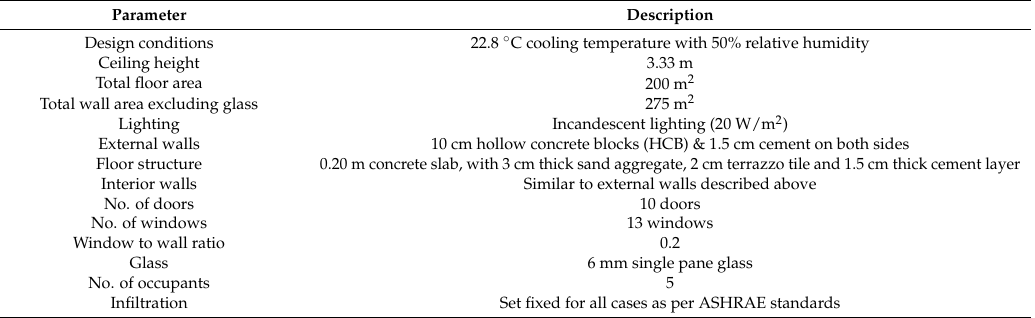
Figure 2. The layout of the house: ( a ) first floor and ( b ) second floor. Table 1. The parameters for the base